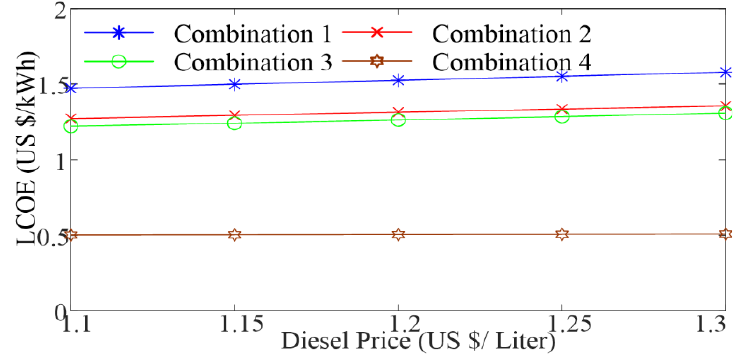
Figure 19. Variation of LCOE with variation in diesel price.